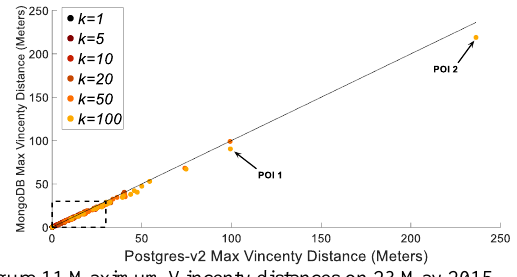
Figure 11 Maximum Vincenty distances on 23 May 2015 The results are in-line with what had been observed on the year- long analysis and that MongoDB outperformed Postgres in terms of spatial accuracy. In this analysis, two points deserve attention.